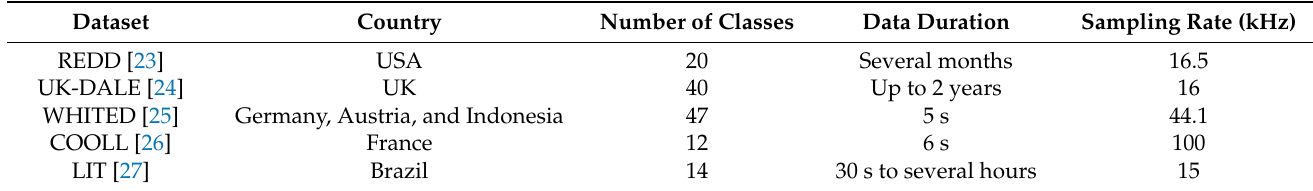
Table 1. Summary of selected benchmark datasets: REDD, reference energy disaggregation dataset; UK-DALE, United Kingdom domestic appliance-level electricity dataset; WHITED, worldwide household and industry transient energy dataset; COOLL, controlled on/off loads library dataset; LIT, laboratory for innovation and technology in embedded systems dataset.